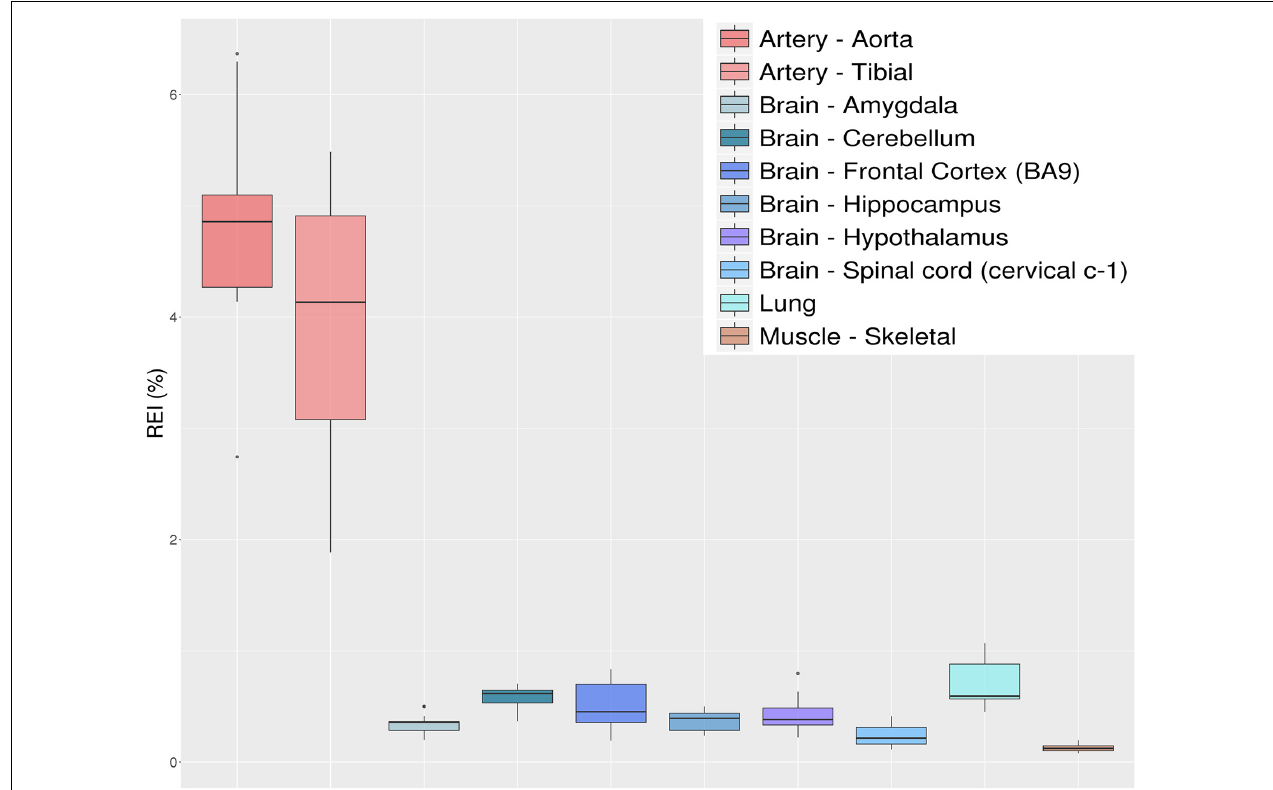
FIGURE 8 | Distributions of recoding editing index (REI) values over 10 selected tissues from the GTEx project reported as box-plots. REI is calculated as the weighted average of editing levels over all known recoding sites from the REDIportal database. Most brain sub-tissues show similar levels of recoding editing. A remarkable exception is represented by the aorta and tibial artery showing a surprisingly high editing level.